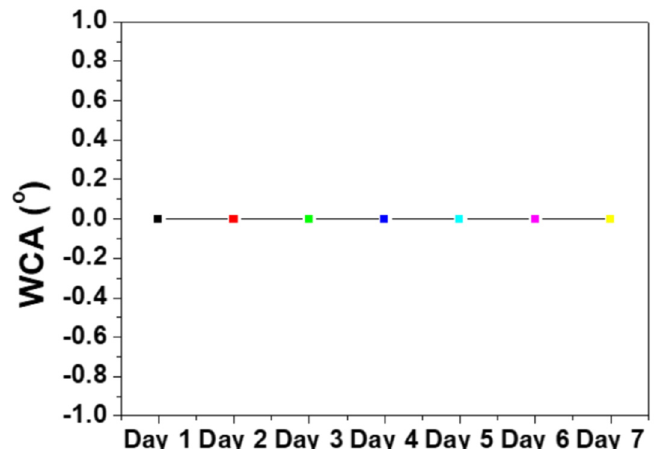
Figure 9. Stability of super-hydrophilicity of TiO 2 ̶ KH550 ̶ PEG -coated glass in darkness.